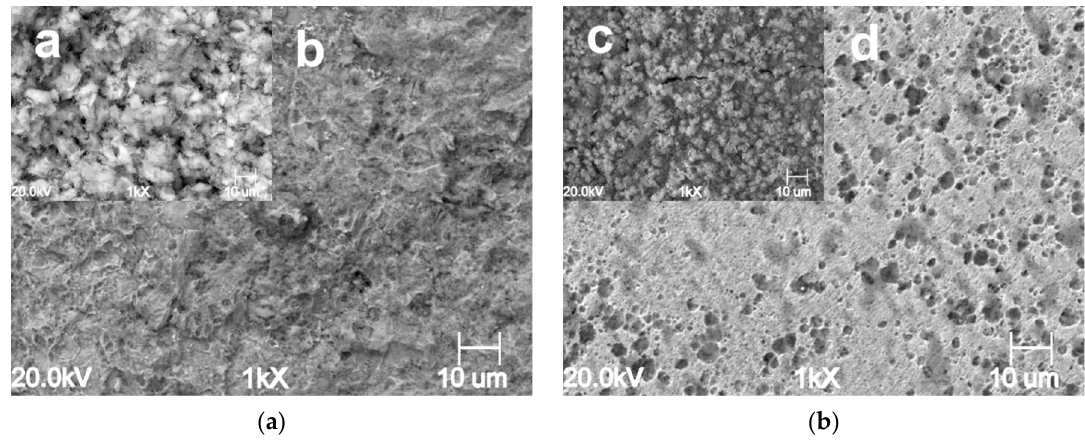
Figure 13. SEM images of the N80 carbon steel morphology after 168 h of immersion in the tested solution in the presence of 1.0 g L − 1 of GA at P CO at 25 °C.